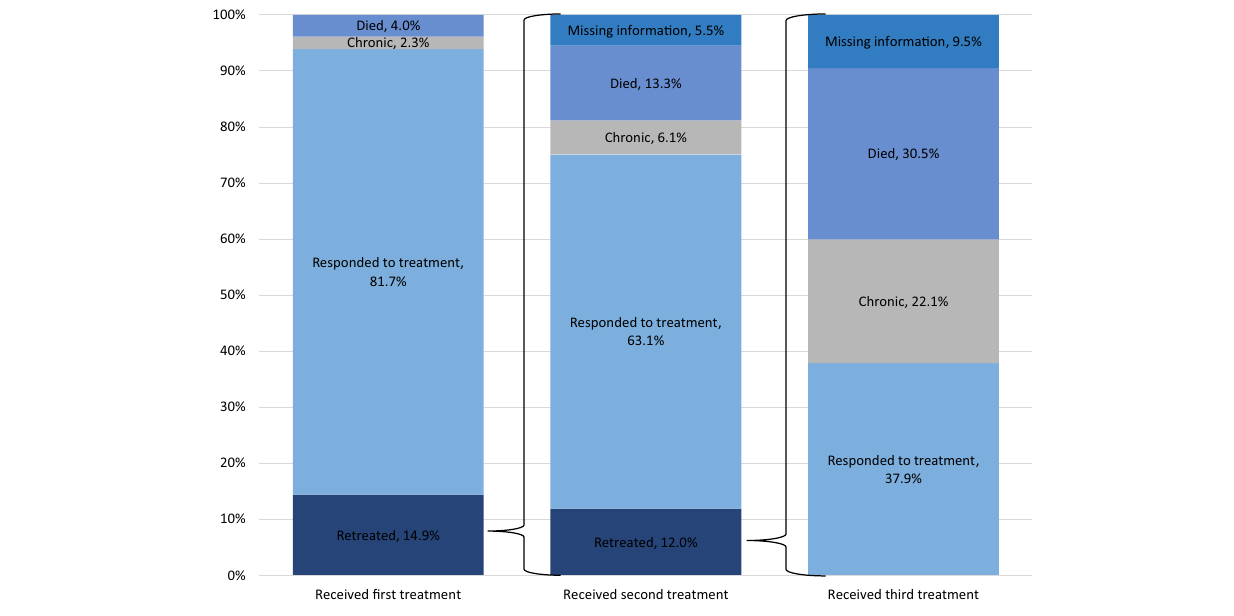
FigUre 1 | US feedlot cattle affected by bovine respiratory disease, measured as percentage of national herd by category. Source: National Animal Health Monitoring System Beef Feedlot 2011 Study.